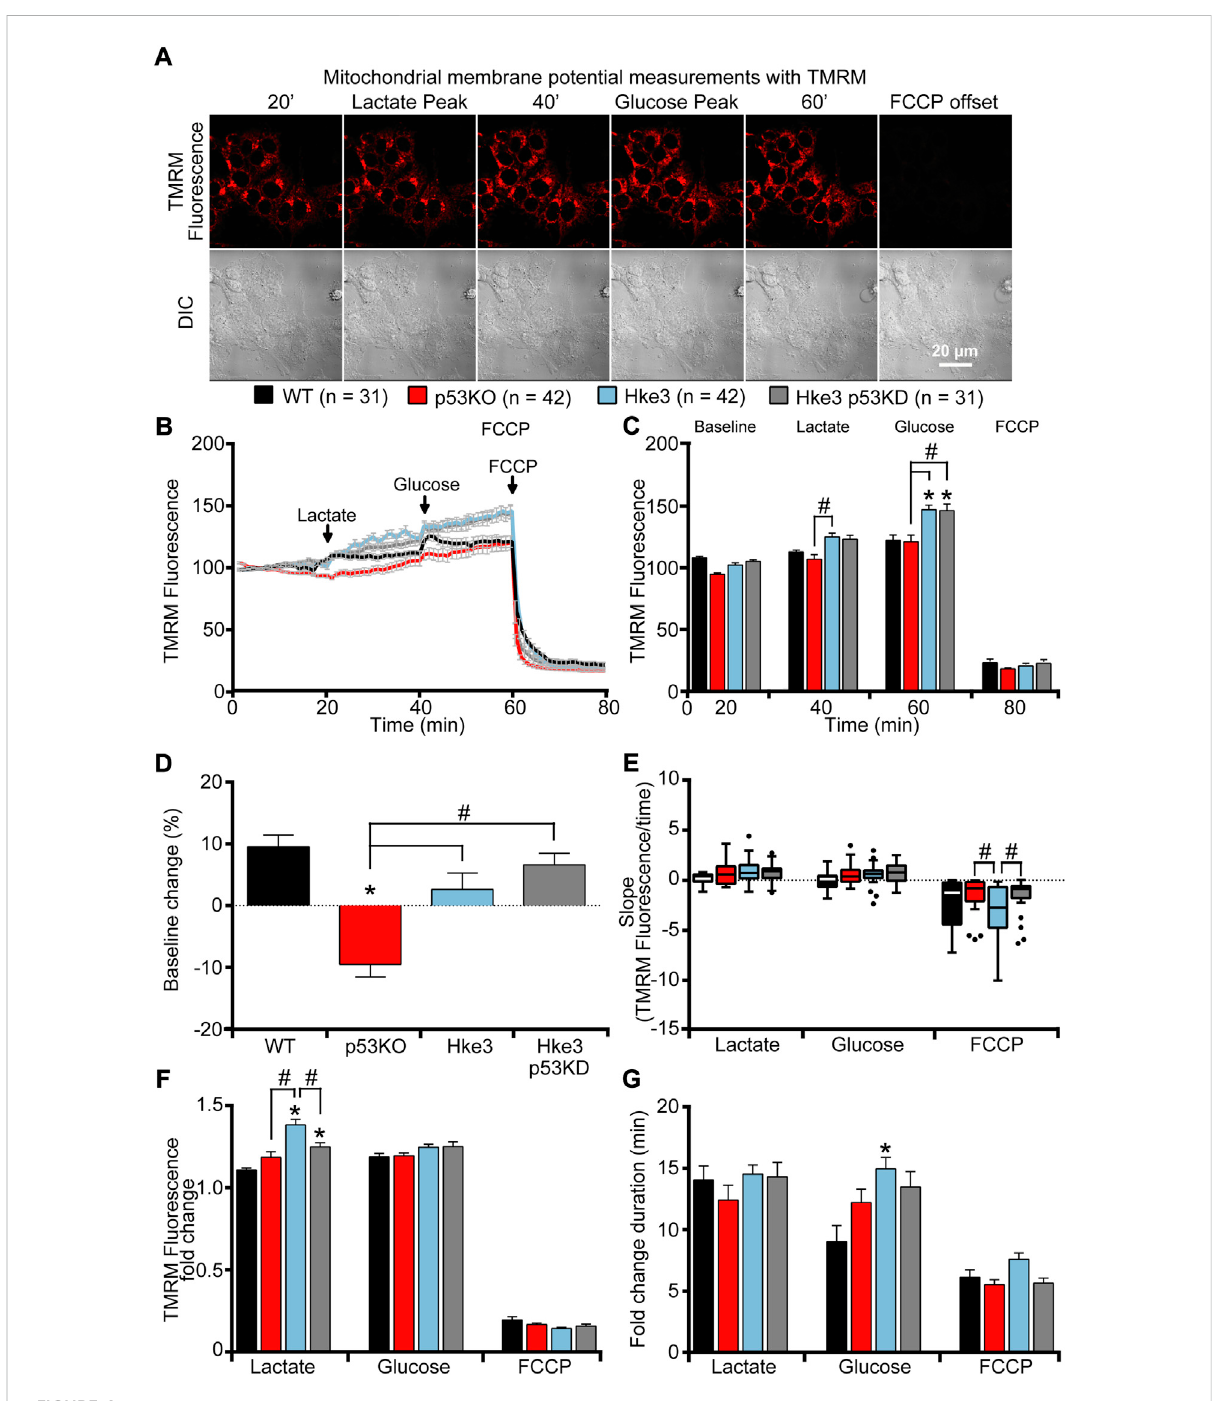
FIGURE 4 KRAS mutation leads to minimal mitochondrial membrane potential changes in response to metabolic substrates. WT, p53 KO, Hke3 and Hke3p53KDHCT-116cellswereseparatelyloadedwith30 nMTMRMasa Δ ψ m indicator(non-quenchedmode),mountedontheheatedstageofan LSM 710 confocal microscope and assayed over 80 min at 37 ° C. Cells were exposed as mentioned and illustrated in Figure 1A. DIC and fl uorescent measurementswererecordedforTMRMbytime-lapseconfocalmicroscopy.Mitochondrialmembranepotentialimagingdataareexpressedas a fl uorescence intensity normalized to baseline. (A) Mitochondrial membrane potential, before and after drugs addition, was analyzed, and TMRM fl uorescence and DIC representative images of Hke3 cells are shown. (B) Kinetics of all cells monitored are shown as means ± SEM. Scale bar = 20 µm. (C) Analysis of TMRM fl uorescence levels before each drug treatment (20, 40 and 60 min) and at the end of the experiment (80 min), additions areindicated withblackarrowsontop. (D) TMRMbaselinelevels overthe fi rst20min, (E) quanti fi cationoftheslopeofTMRM fl uorescence (the change in TMRM fl uorescence intensity over time in minutes), (F) the mean fold change in TMRM fl uorescence intensity (G) and the mean duration for change in TMRM fl uorescence intensity after each treatment are illustrated. Means ± SEM are shown from at least three independent experiments for each cell line (WT, n = 31; p53 KO, n = 42; Hke3 n = 42; Hke3 p53 KD, n = 31). * p ≤ 0.05 compared to WT control cells; # p ≤ 0.05 between cell lines (ANOVA, post-hoc